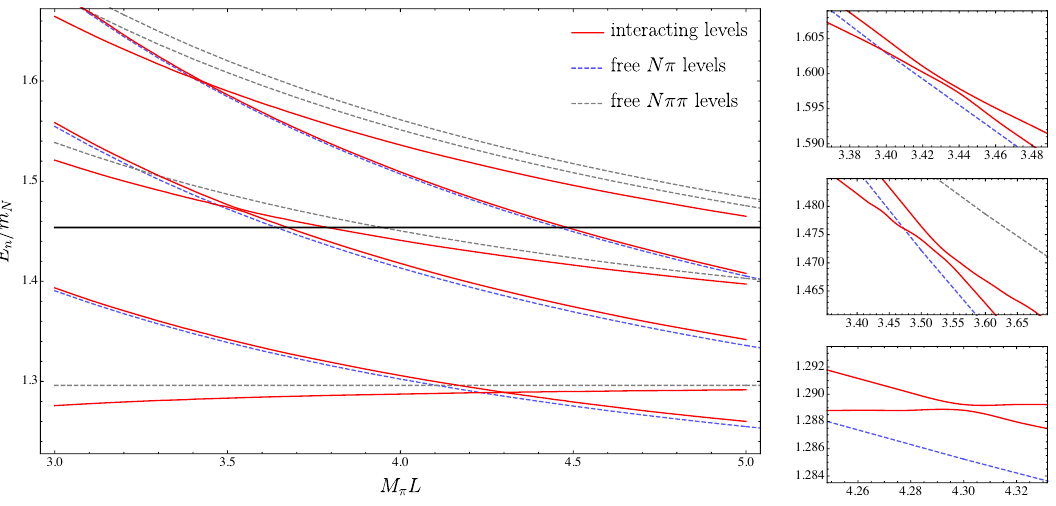
Figure 6 . Energy levels for different box sizes L considering the coupled channel with Nπ and Nσ self-energy contributions. Red lines display the numerical results for the interacting energy levels. Blue dashed and grey dashed lines show the non-interacting Nπ and Nππ energy levels, respectively. The thick solid black line marks the mass of the Roper resonance. The small pictures on the right-hand side show the three critical points where the interacting energy levels come very close to each